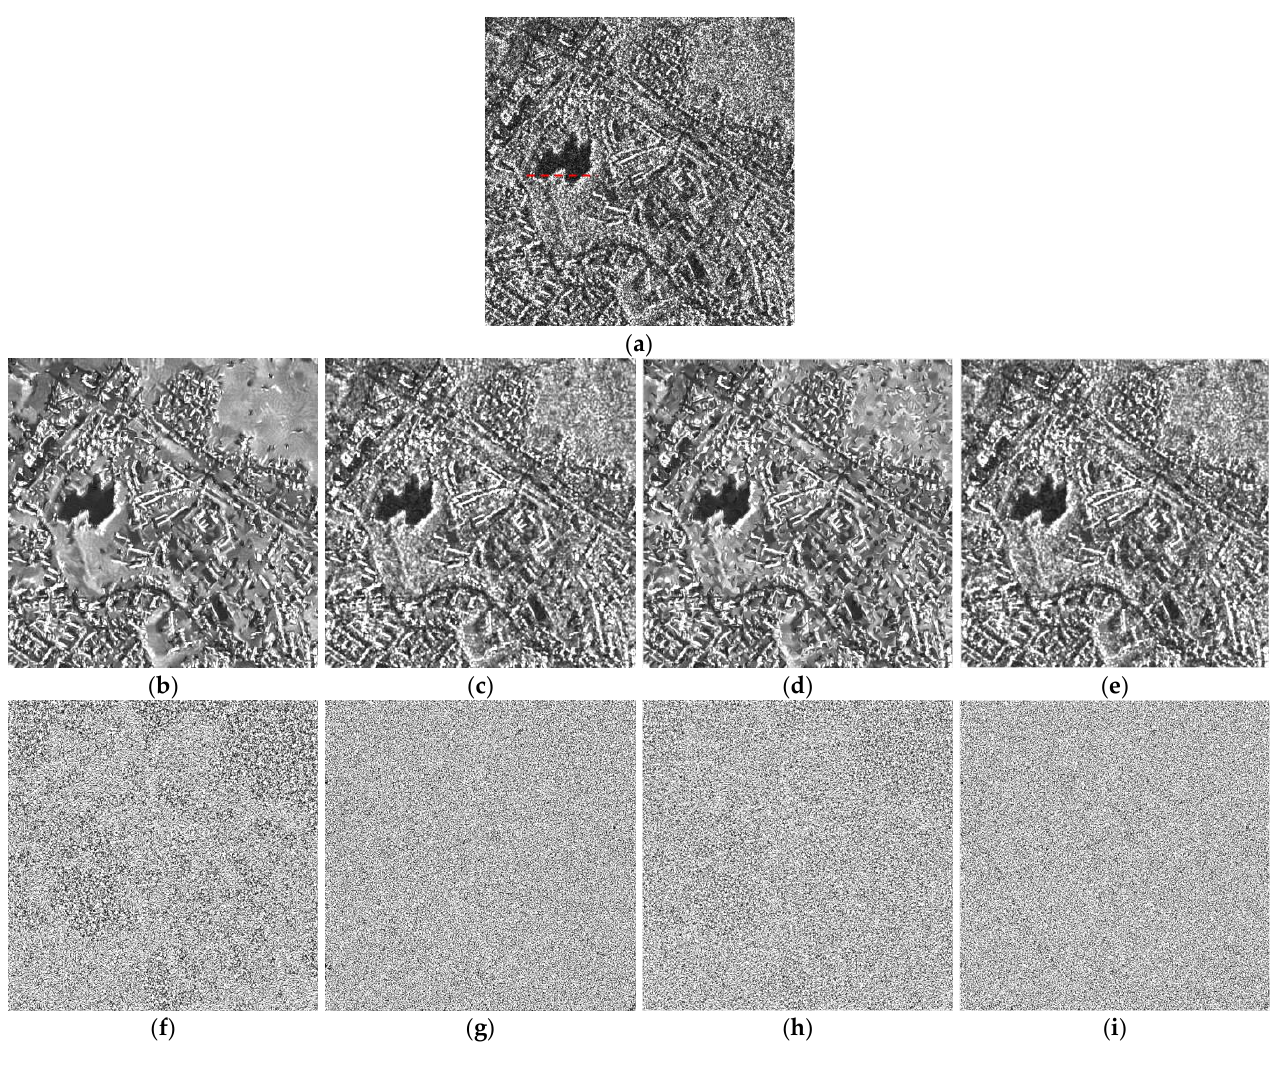
Figure 6. Filtering results for the TerraSAR-X Image. ( a ) The speckled image. ( b , c ) are, respectively, the PPB and SAR-BM3D filtered image with S = 7 × 7. ( d , e ) are, respectively, the PPB and SAR-BM3D filtered image with S = 5 × 5. ( f – i ) are the corresponding ratio images of ( b – e ). Table 5. EPC assessment results for the TerraSAR-X image.